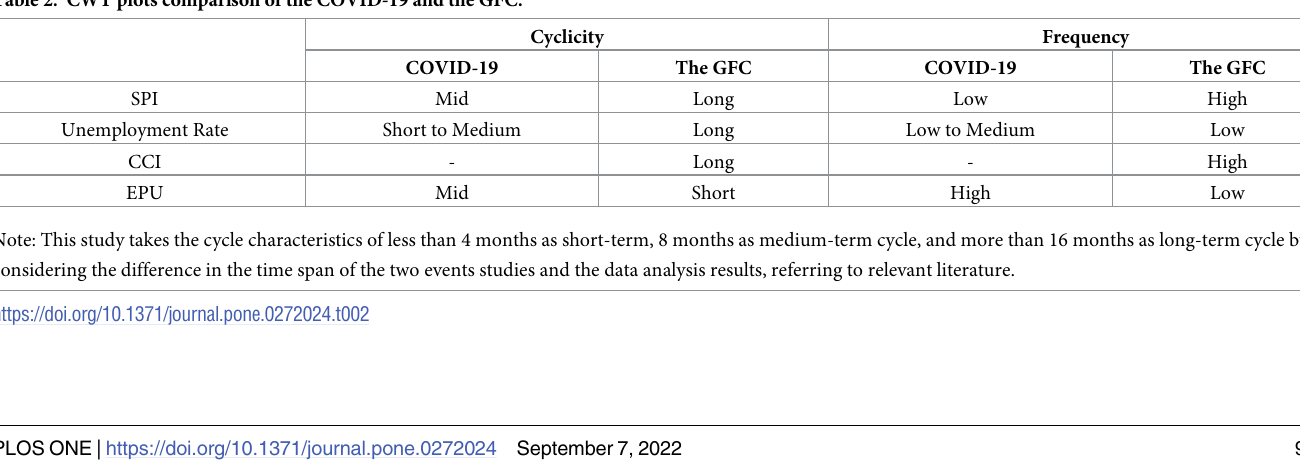
Table 2. CWT plots comparison of the COVID-19 and the